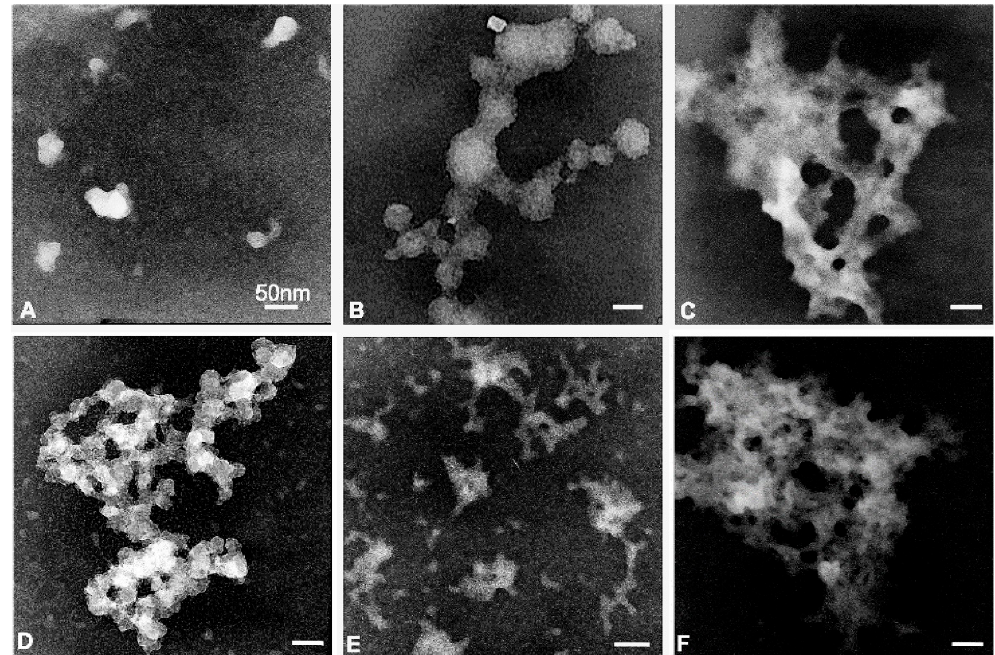
Figure 2. Ultrastructure of copper metallodendrimers visualized by transmission electron microscopy (TEM): ( A ) CCD-NO-0, ( B ) CCD-NO-1, ( C ) CCD-NO-2, ( D ) CCD-Cl-0, ( E ) CCD-Cl-1, (F) CCD-Cl-2. Dendrimers were dissolved in Na-phosphate buffer 10 mmol/L, pH7.4. Bar = 50 nm.